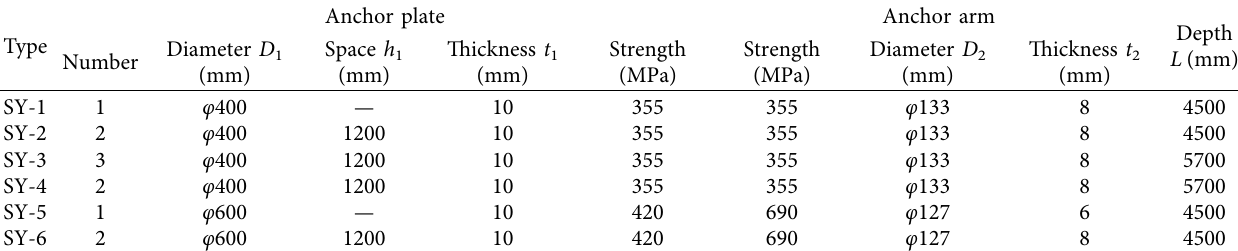
Table 1: Specimen